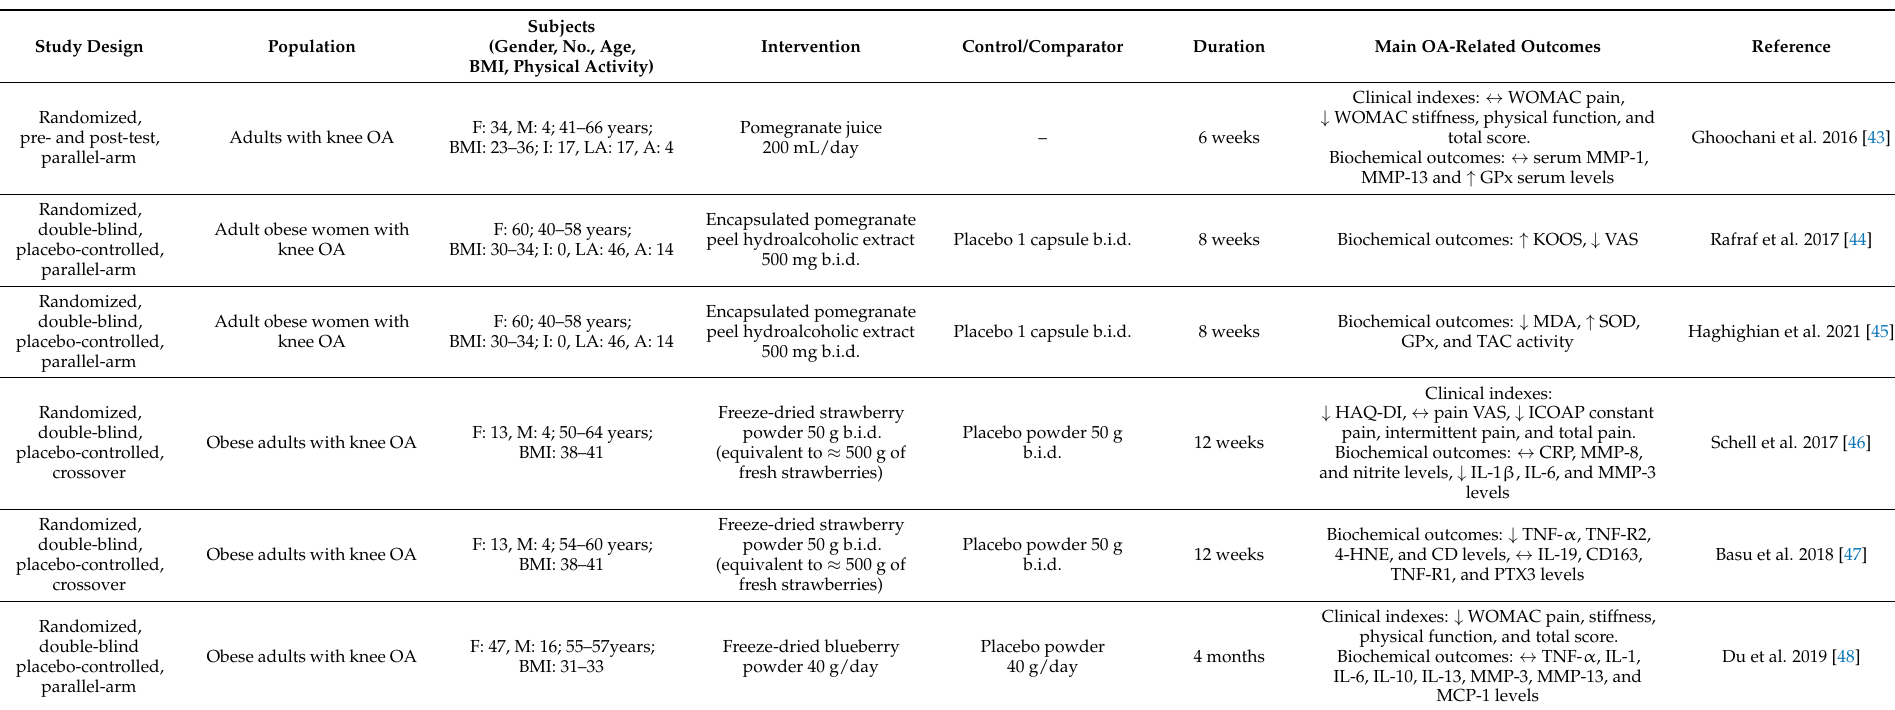
Table 1. Summary of findings related to HT-containing product consumption and OA in humans (see Table S1 for specific details on sample preparation and characterization of the tested